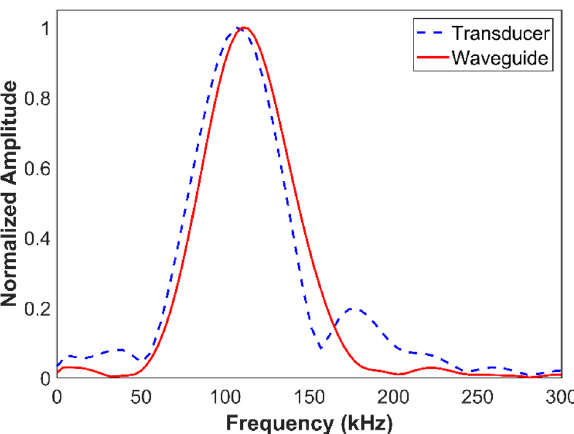
Figure 4. Experimental results showing the comparison of frequency spectrums received with and without waveguide attachment to the transducer. Waveguide allows broadband reception by not limiting the frequency range that the attached transducer can receive.